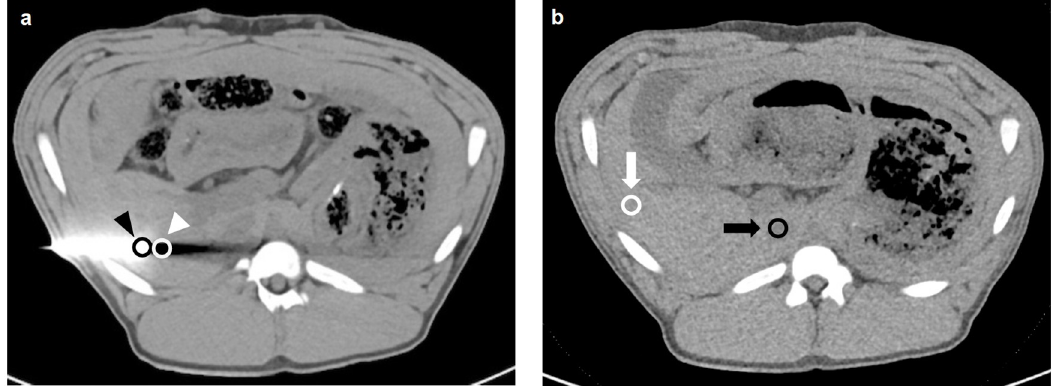
Fig 2. Image example for the placement of regions of interest. Axial image with trocar (a) with ROIs at the trocar tip (black arrowhead) and in the liver parenchyma adjacent to the trocar tip (white arrowhead). Axial slice without any visible artifacts (b) with ROIs in the liver parenchyma (white arrow) and inferior vena cava (black